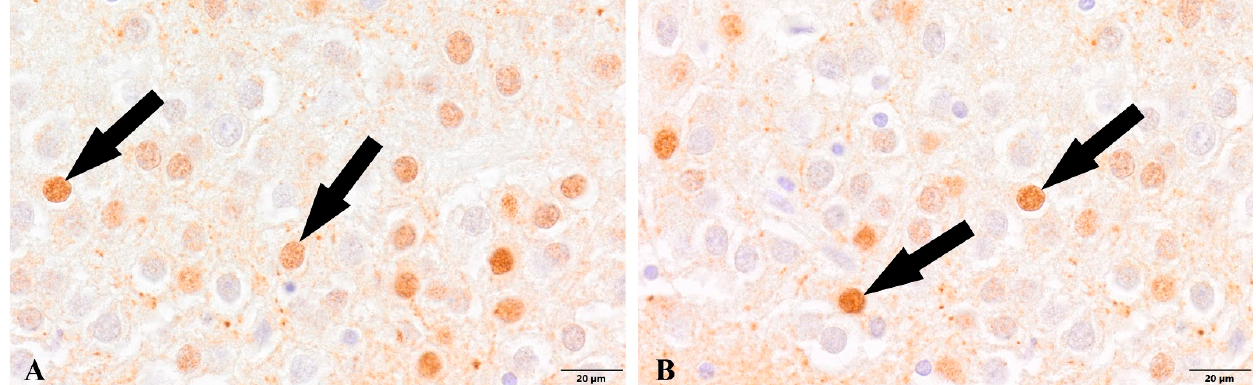
Figure 5. Dentate gyrus, newborn neurons (arrows). ( A ). Control group. ( B ). Group patients with diagnosed COVID-19. Immunolabeling NeuN antibody.